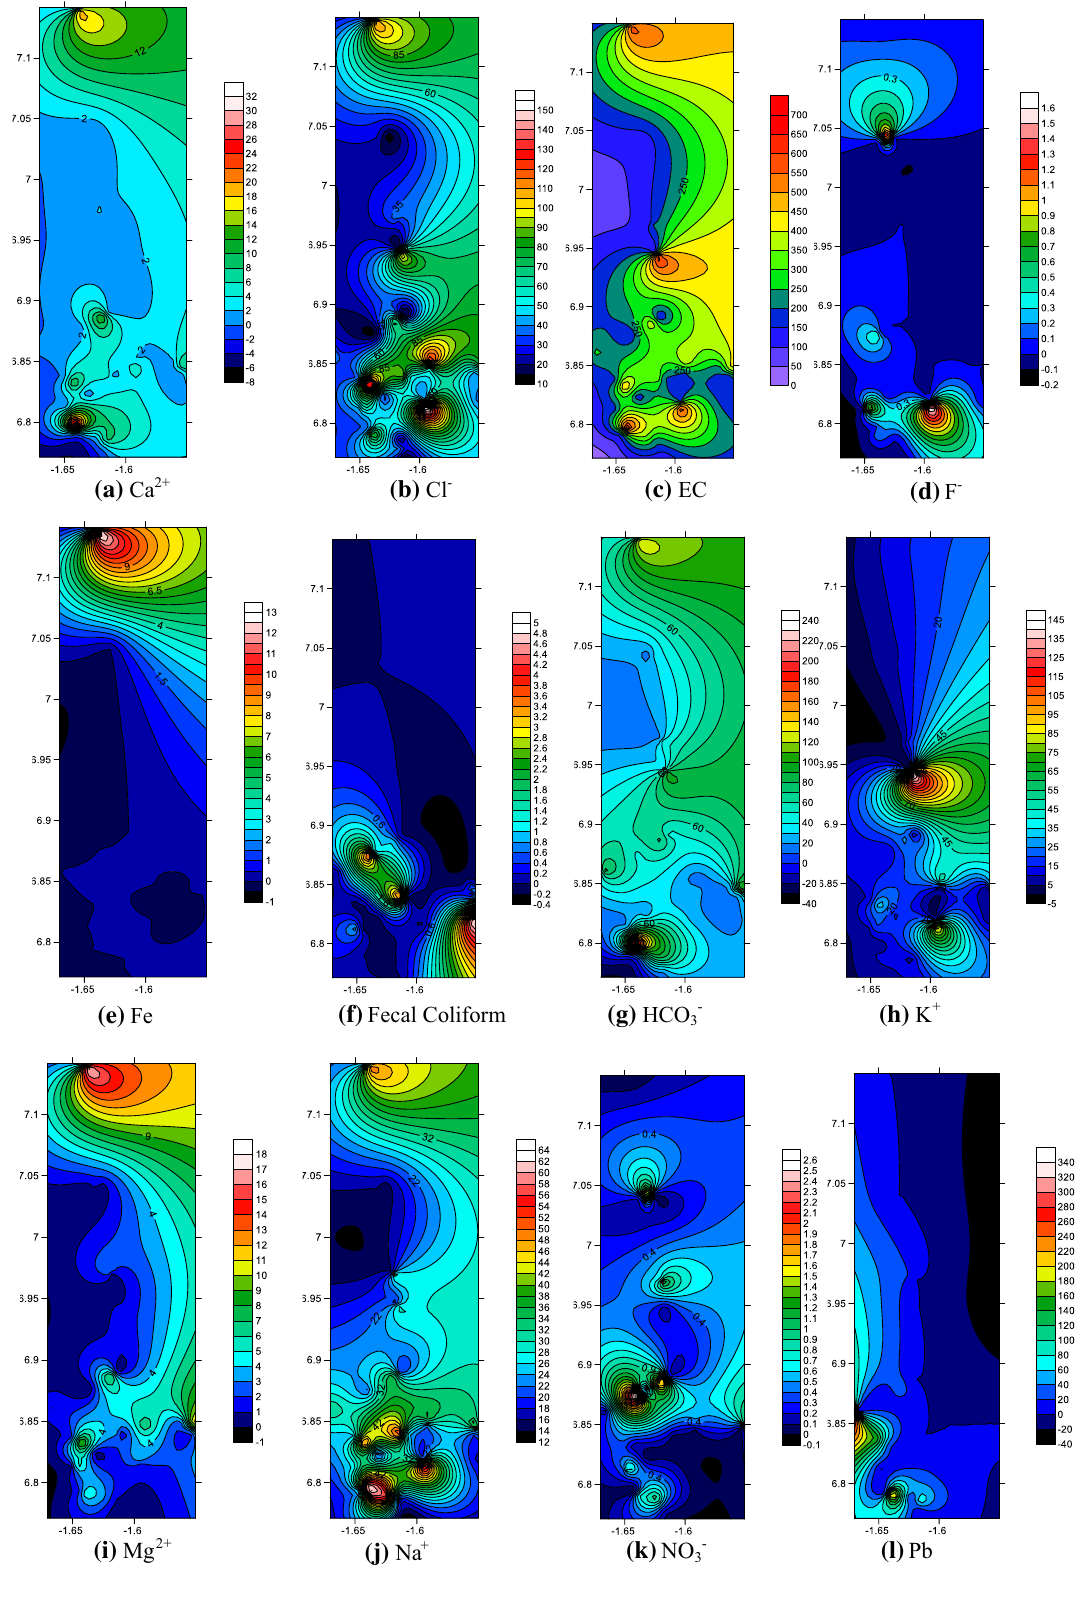
Fig. 2 a – r : Thematic maps of selected groundwater quality parameters in the study